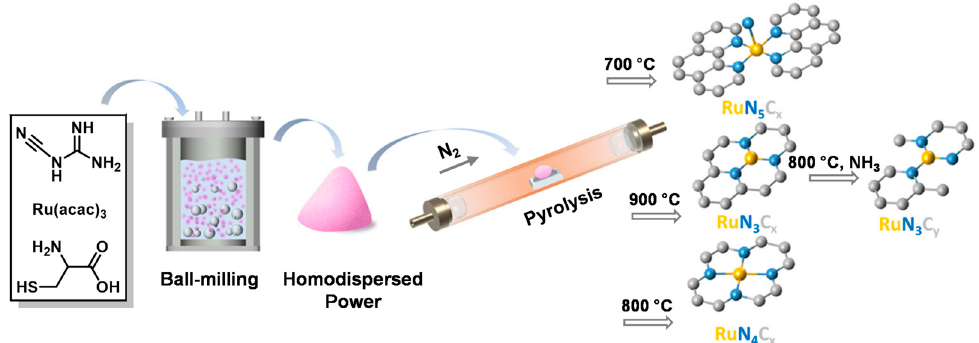
Figure 3. Schematic illustration for the synthesis procedure of Ru 1 /NC-T catalysts. Adapted with permission from ref [28]. Copyright 2021 The